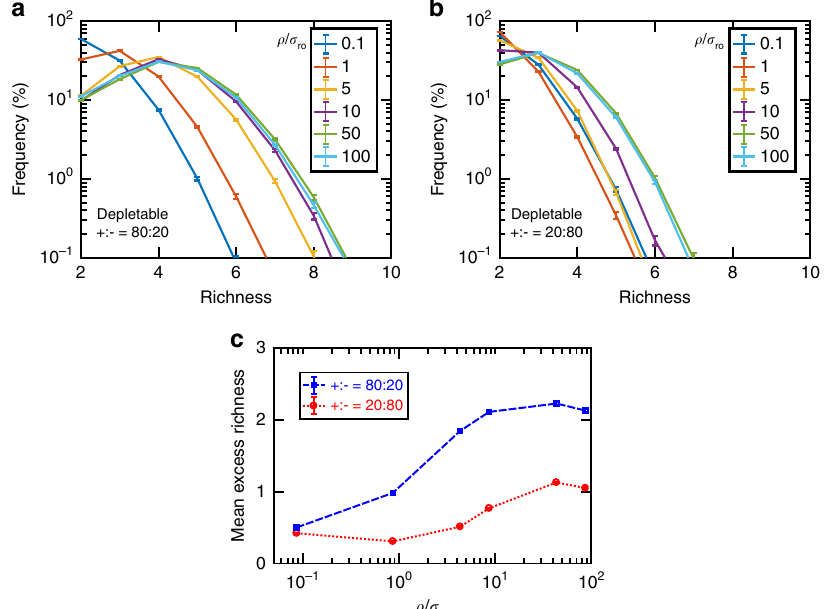
Fig. 3 Coexistence is disrupted at weak in fl uence strengths. Whether in fl uences are mostly facilitative ( a ) or inhibitory ( b ), as interactions become stronger (i.e., larger ρ / σ r 0 values, where ρ is the average in fl uence strength and σ r 0 is the standard deviation of net basal growth rates in the initial pool), coexistence becomes more likely, but this trend saturates at strong in fl uences. At very weak in fl uence strengths, we can assume that coexistence happens only for species with very similar growth rates, approaching the neutral theory prediction in Fig. 2. Here the initial number of species types N c = 20 and the number of possible mediators N m = 15. Error bars indicate s.d. due to sampling. c Mean excess richness indicates average richness in derived communities beyond single-species dominance predicted by competitive exclusion principle (see Methods). Stronger interactions appear to contribute to more coexistence in a saturating form. Error bars show bootstrap estimates of 95% con fi dence intervals for the mean